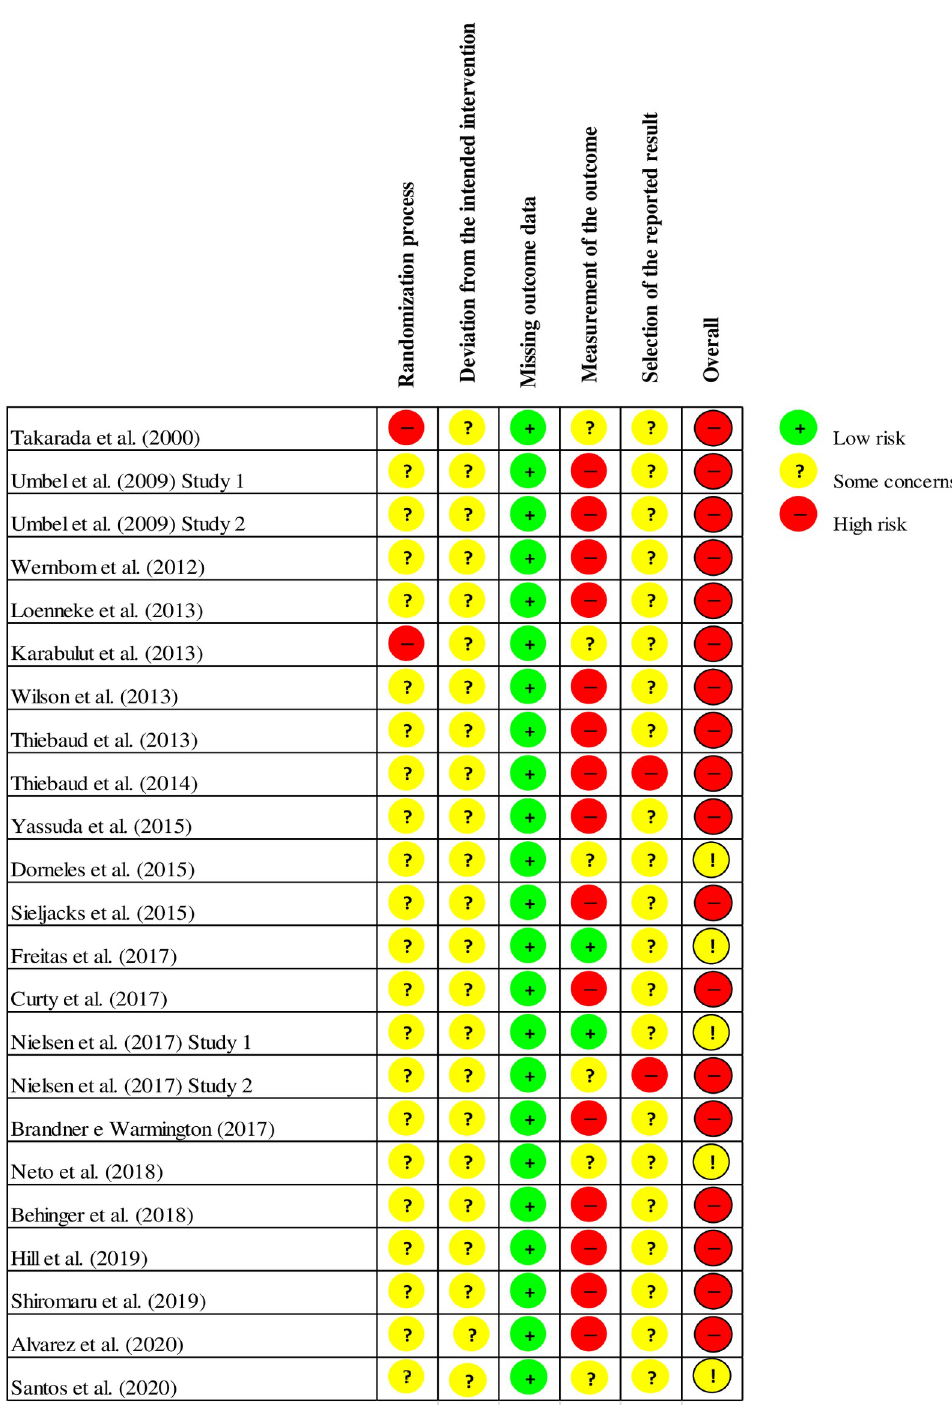
Fig 2. Graph of risk of bias for the studies included in the